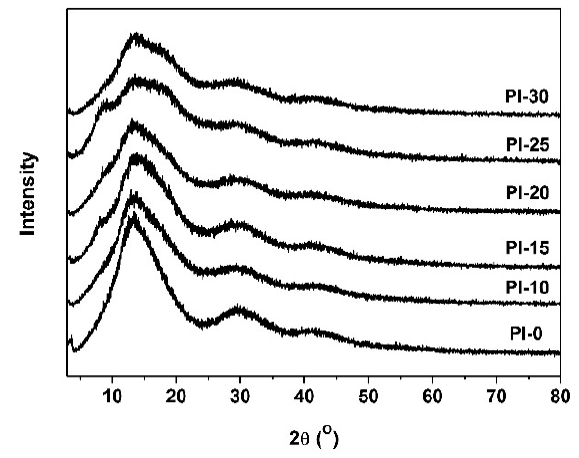
Figure 6. CIE Lab color parameters of POSS ‐ substituted poly (pyromellitic anhydride ‐ 4,4 ′‐ oxydianiline) (PMDA ‐ ODA) films (POSS ‐ PI) films. ( a ) Two ‐ dimensional (2D) map; and, ( b ) three ‐ dimensional (3D) map.